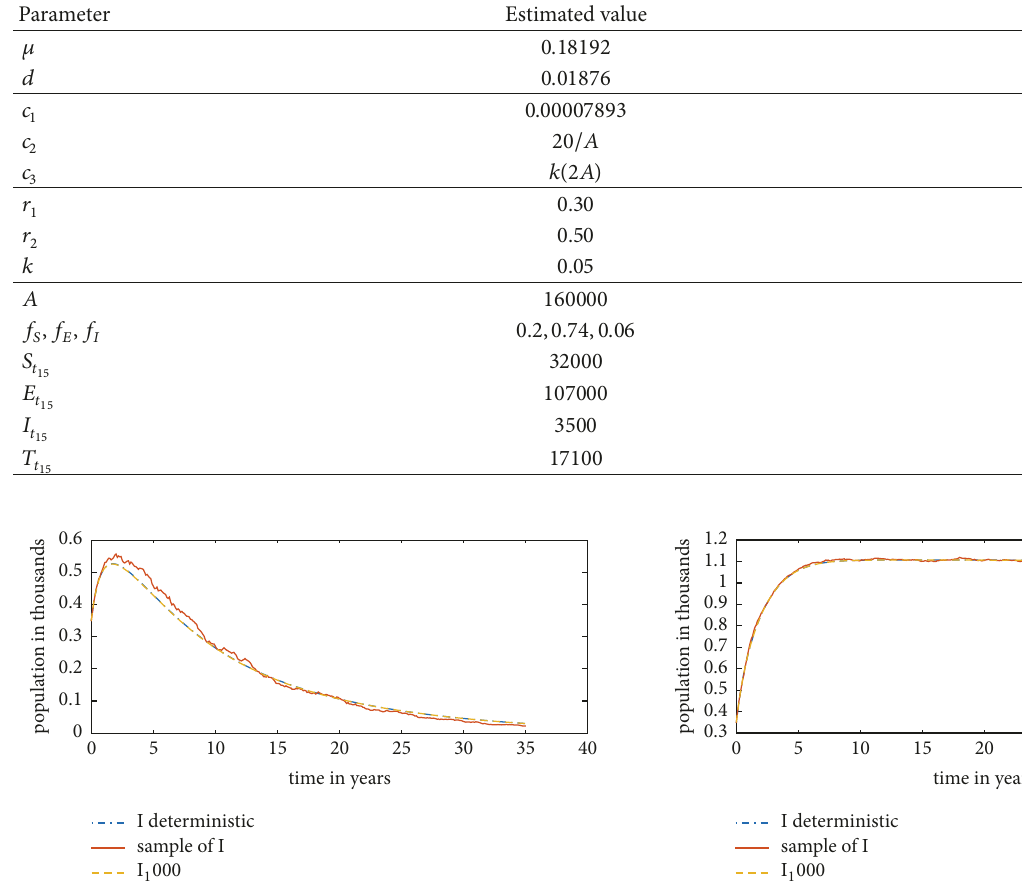
converge to zero. This means that the disease will persist in our prison population.